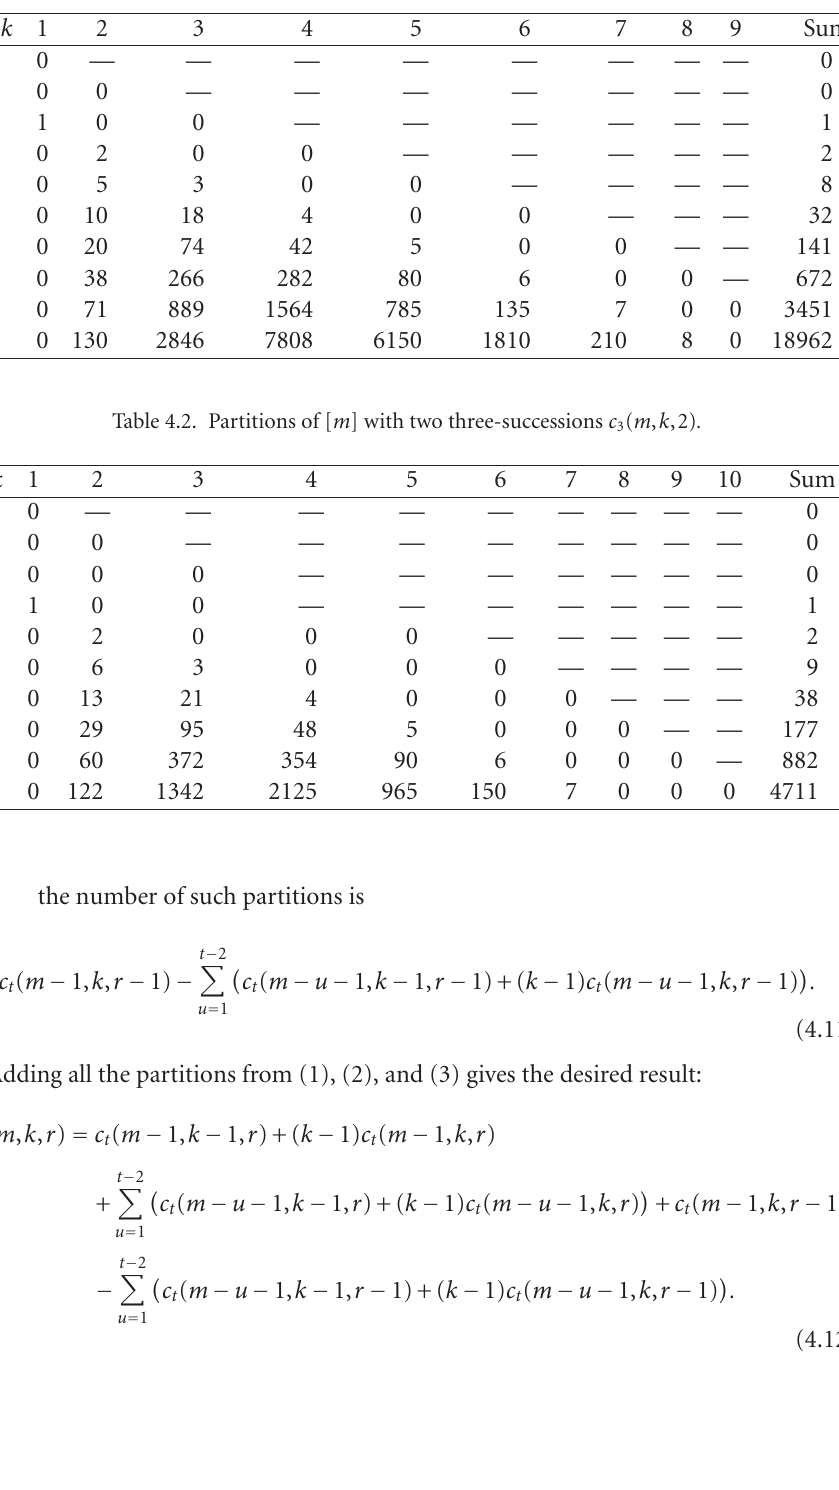
Table 4.1. Partitions of [ m ] with one three-succession c 3 ( m , k ,1).